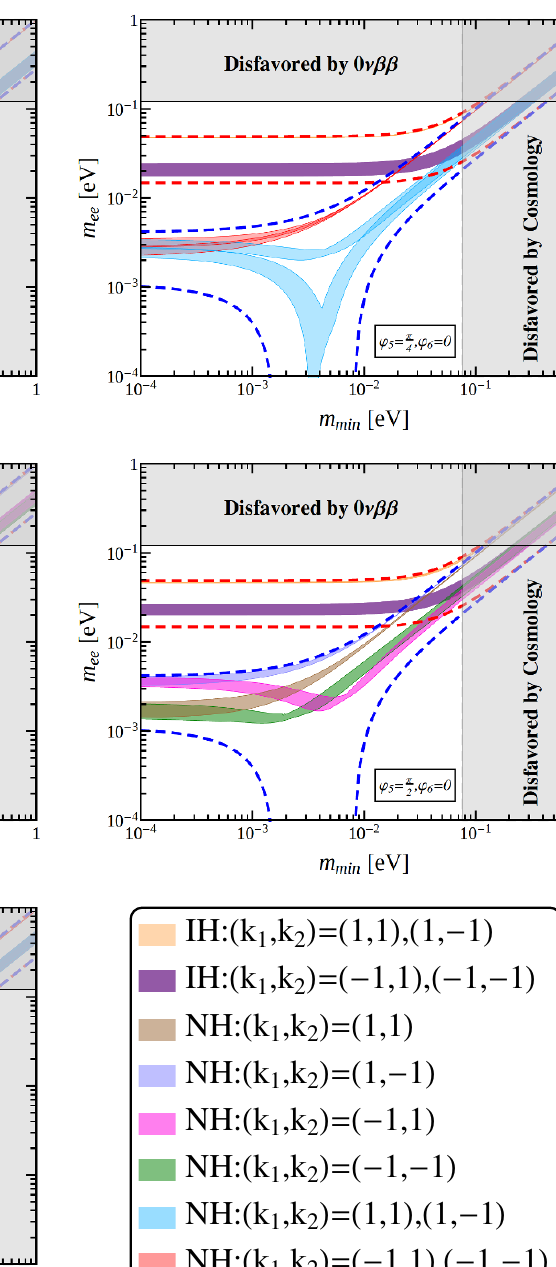
Figure 11 . The possible values of the e(cid:11)ective Majorana mass m ee as a function of the lightest neutrino mass m min for the mixing patterns U III ; 2 and U III ; 4 . The red (blue) dashed lines indicate the most general allowed regions for IH (NH) neutrino mass spectrum obtained by varying the mixing parameters over their 3 (cid:27) ranges [8]. The present most stringent upper limits m ee < 0 : 120 eV from EXO-200 [85, 86] and KamLAND-ZEN [87] is shown by horizontal grey band. The vertical grey exclusion band denotes the current bound coming from the cosmological data of P m i < 0 : 230 eV at 95% con(cid:12)dence level obtained by the Planck collaboration [88].